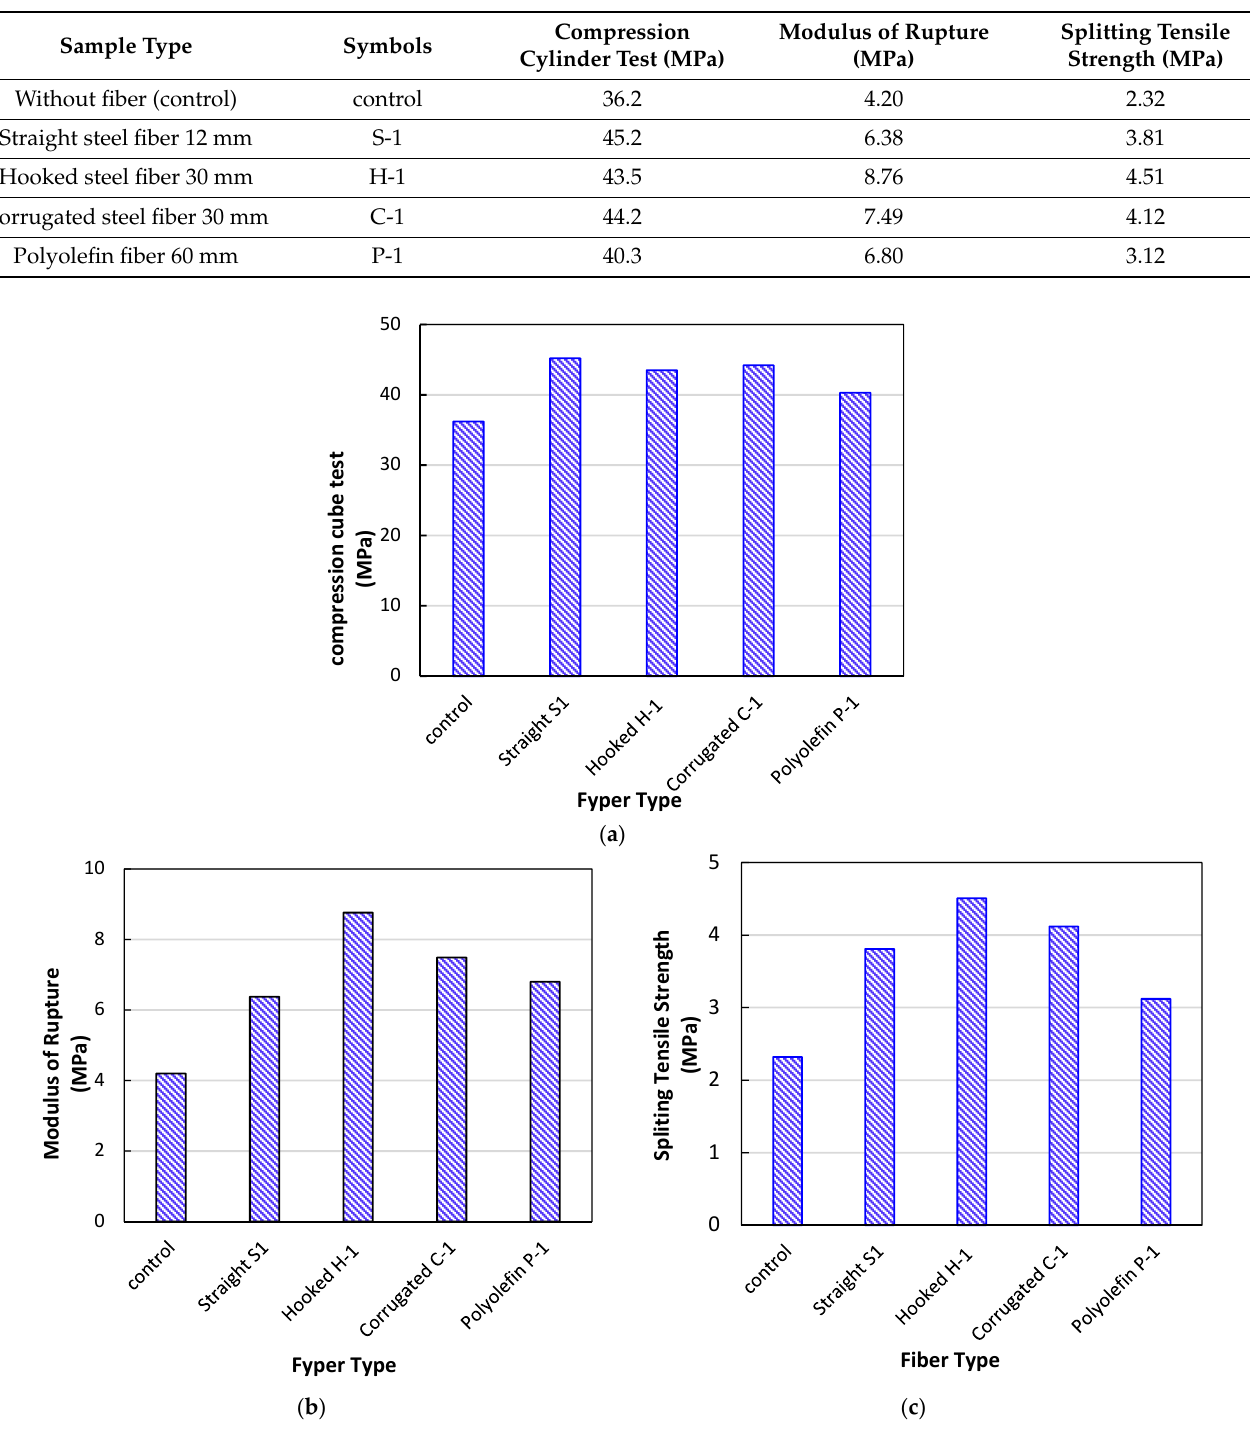
Figure 5. Mechanical properties of concrete mix with fiber as: ( a ) Compression cube test; ( b ); Modulus of Rupture; ( c ) Splitting Tensile Strength.